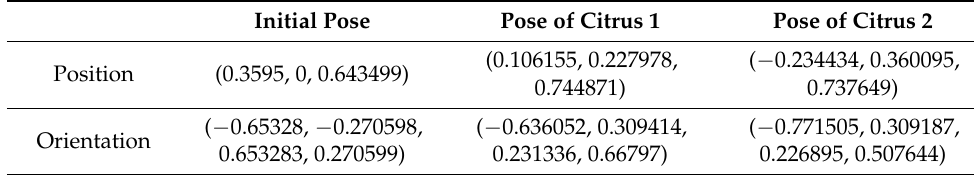
Figure 13. The shortest distance from the center of the sphere to the origin of the coordinate system of adjacent links of the manipulator. ( a ) Obstacle with coordinates (25,55,48); ( b ) Obstacle with coordinates (25,53,47); ( c ) Obstacle with coordinates (25,51,46); ( d ) Obstacle with coordinates (25,49,45). C i C i + 1 represents the distance between the line segment between coordinate system i and coordinate system i + 1 and the center of the sphere. Table 5. Experimental parameters.